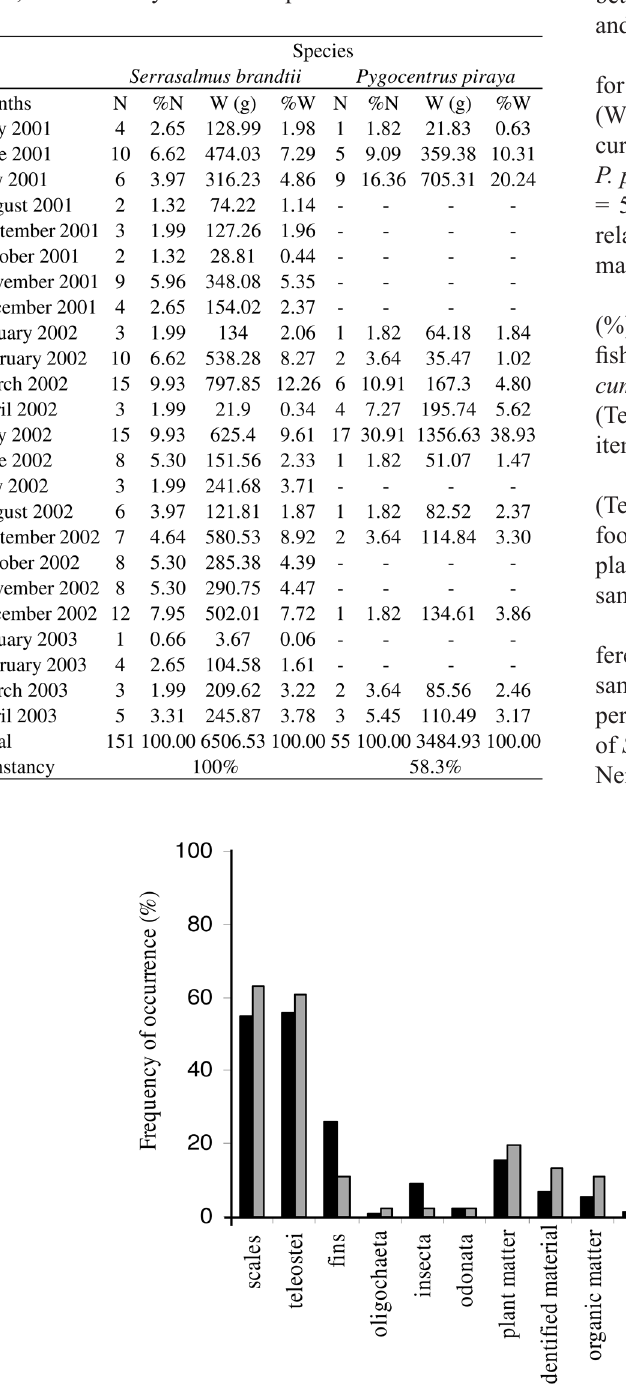
Table 1. Frequency of absolute (N) and percent occurrence (%N), absolute (W) and percent biomass (%W), and constancy of two serrasalmin species along a stretch of the rio de Contas, Bahia, between May 2001 and April 2003.